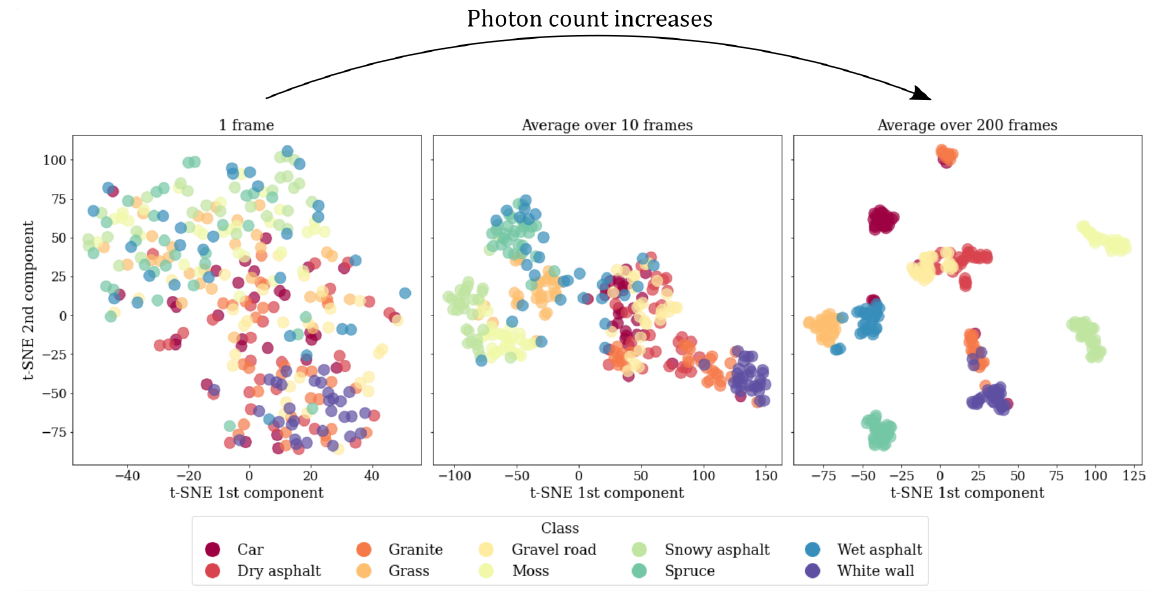
Figure 16. A visualization of the dataset samples that have been embedded in a two-dimensional t-SNE space (perplexity = 5.0). The input data consist of the relative spectral reflectance curves that have been accumulated over a single frame (left-hand side), 10 frames (centre), and 200 frames (right-hand